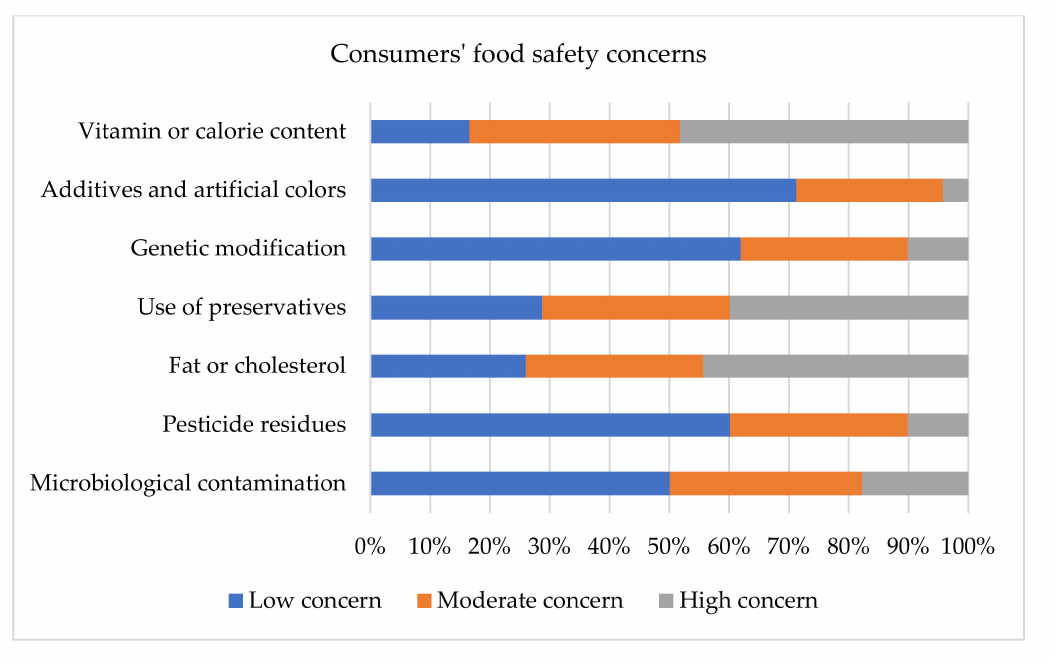
Figure 3. Consumers’ safety concerns toward fish were identified based on five-point Likert scaling where the horizontal axes indicates the percentage of respondents. Respondents’ scores of 2 or below were regarded as a low concern. Those who gave scores 3 were deemed to be a moderate concern. Lastly, scores of 4 and above indicate their high concern. The vertical axes measures concern type.